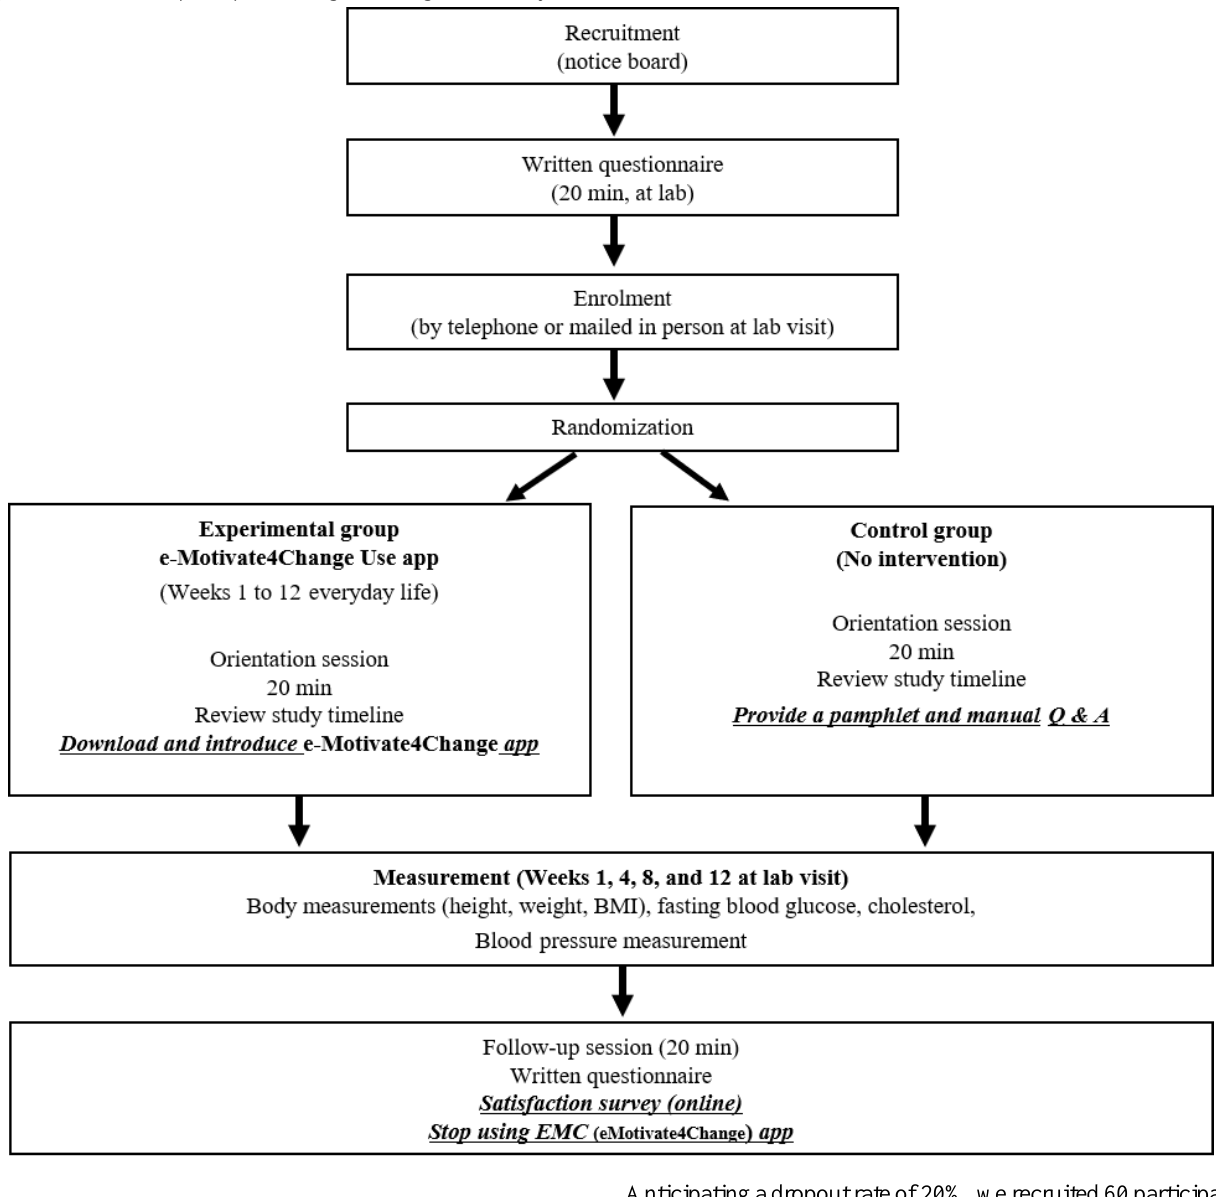
Figure 1. Flowchart of participants through each stage of the